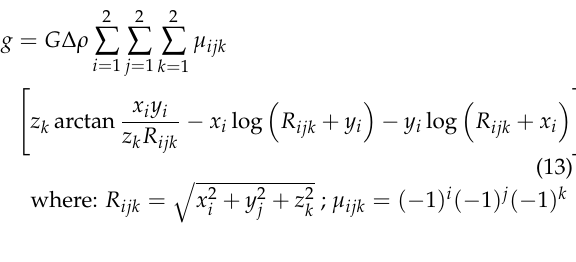
the northwest and a little in the middle, while the anomaly is low in the middle. The high anomaly in the Northwest part is probably related to the geothermal system’s heat source in the Bac-Man field. The low anomaly in the middle part flanking the high anomaly is probably related to a reservoir in the area (Fig. 6)